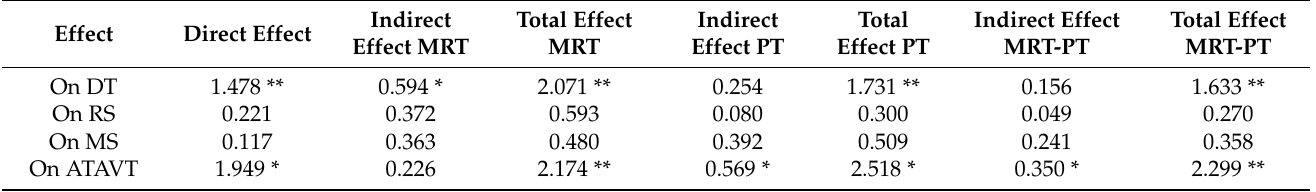
Table 3. Direct, indirect, and total effects of MoCA on resilience of attention (DT), reaction speed (RS), motor speed (MS), and perceptual speed (ATAVT). * indicates p < 0.05, ** indicates p <